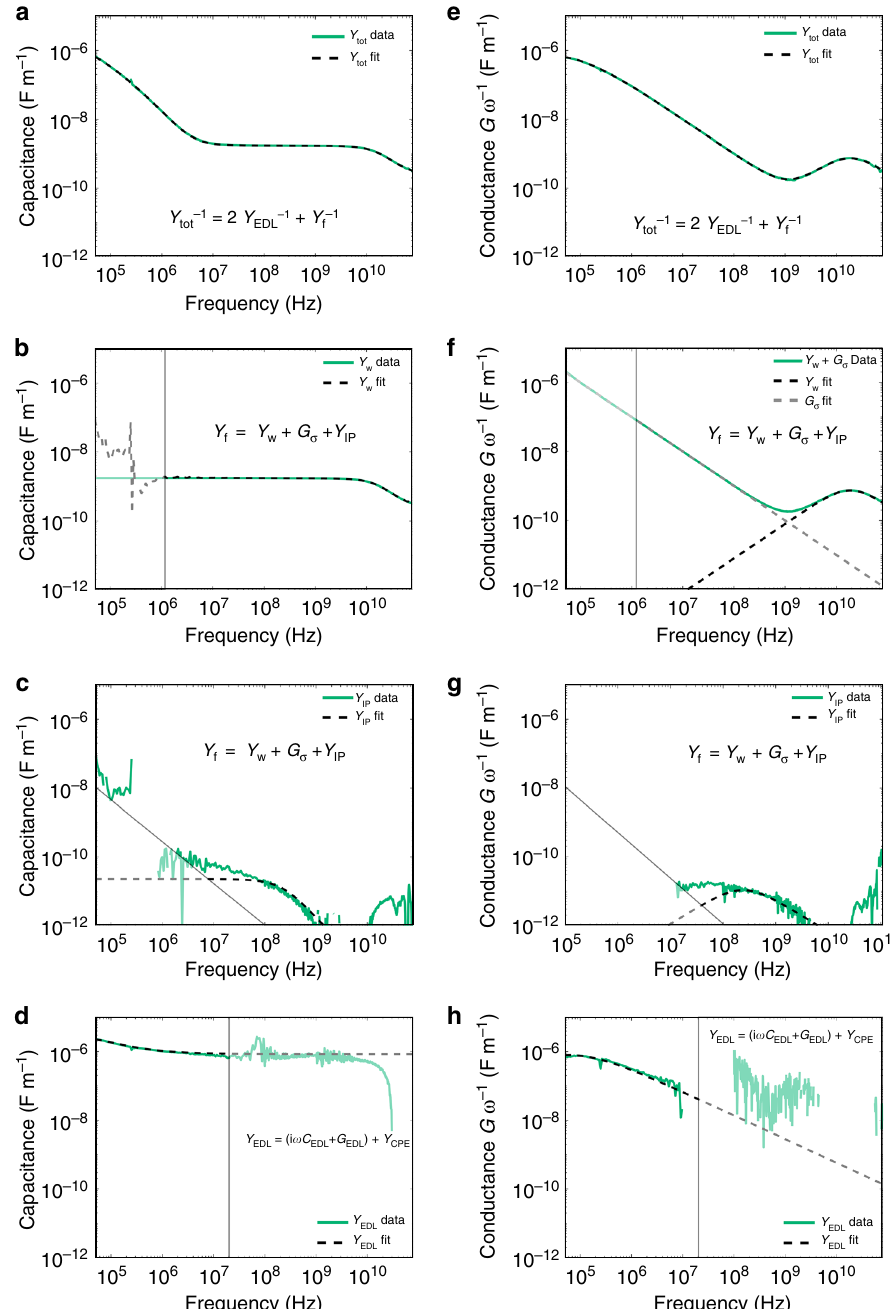
Fig. 5 Example fi tting procedure of Y tot = G tot + i ω C tot for closed DNA tweezer data. Distributed capacitance ( a – d ) and conductance ( e – h ) data are green lines in all plots. All dotted lines are fi tted equations. Data for the individual circuit components are shown by subtracting all other fi tted components from the total distributed capacitance and conductance. a , e Data and fi t of C tot and G tot . b , f Data and fi t of C w , G w (black dotted lines), and G σ (gray dotted line). c , g Data and fi t of C IP and G IP . d , h Data and fi t of C EDL and G EDL . Lighter shaded regions indicate where the extracted parameters are not well conditioned due to a high signal-to-noise individual basis. The open tweezer had a lower conductivity than all control measurements, showing the utility of G σ as a parameter for measuring conformational changes and binding events in DNA-based systems.